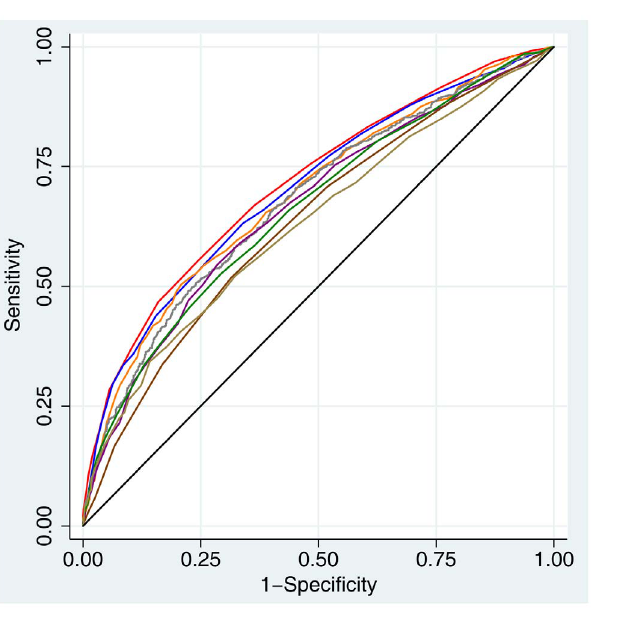
Figure 1. Receiver Operating Characteristic Curves for Various Models Applied to the Study Population in the 6-Year Follow- Up Cohort in Beijing and Shanghai, China, 2005–2011. Red, this study (area under the curve [AUC]: 0.714); Blue, Heianza (AUC: 0.701); Orange, Lim (AUC: 0.689); Gray, Sun (AUC: 0.678); Purple, Chien (AUC: 0.665); Green, Chuang (AUC: 0.661); Pink, Liu (AUC: 0.634); Brown, Doi (AUC: 0.631); Black, reference (AUC: 0.500).